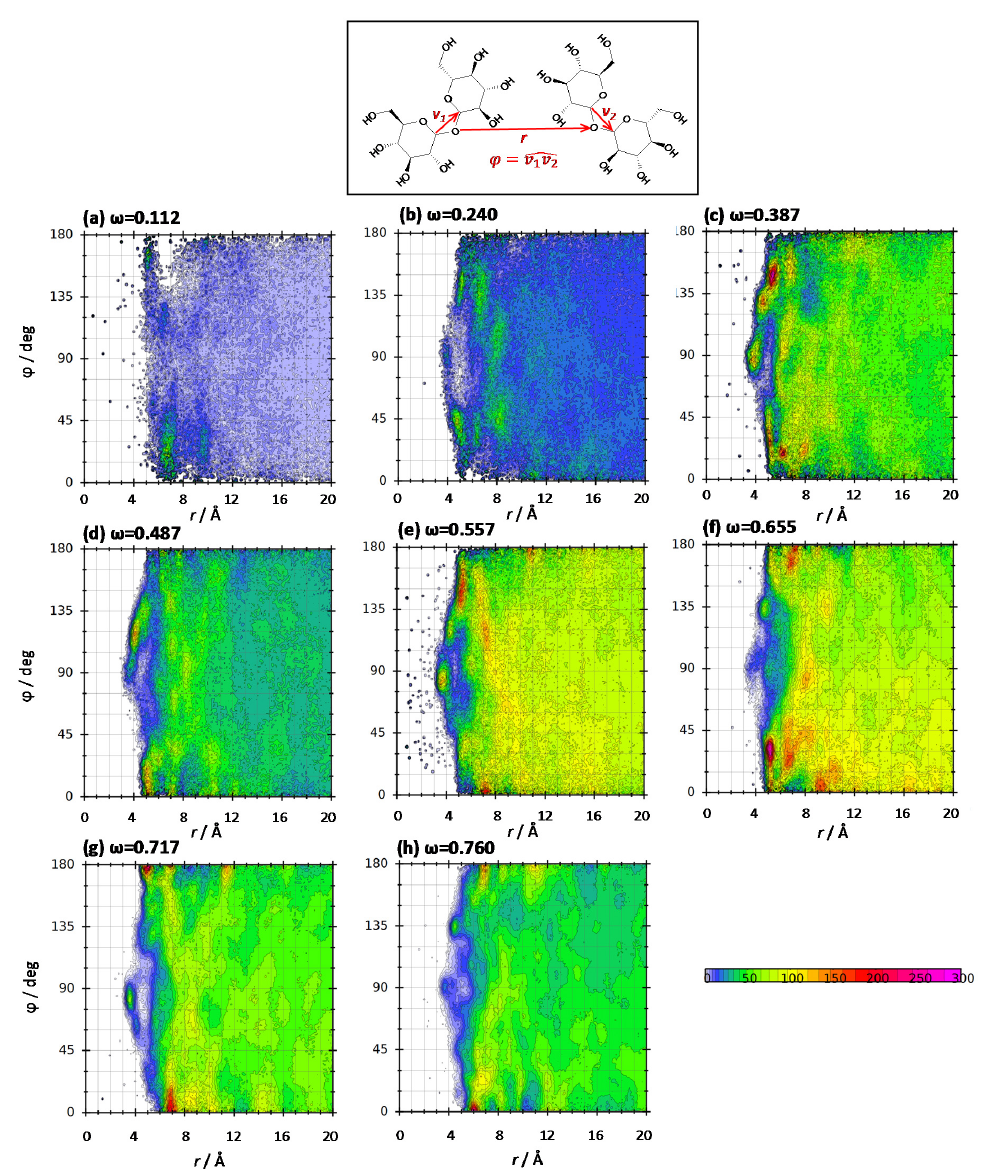
Figure 12. Combined distribution function for the reported distance and angle in ω THAL + (1- ω ) water mixtures at 310 K.